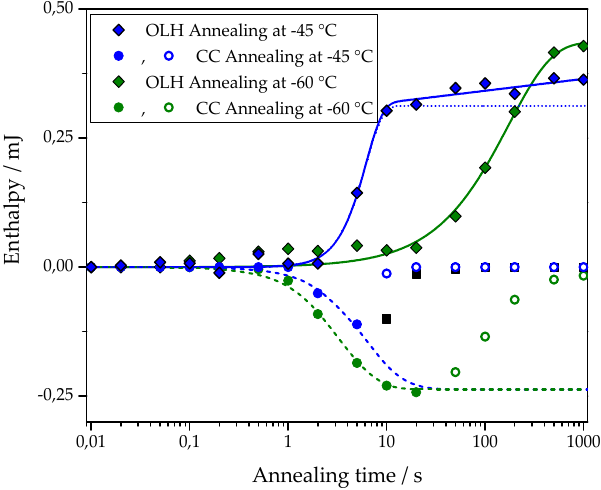
Figure 5. Approximation of the dependence of overall latent heat data (OLH, diamond) on the annealing time with Equation (1) (solid lines). Data for cross-linked PCL with 5% BPO and annealing at − 45 °C (blue symbols) and at − 60 °C (olive symbols). The dotted line shows the primary crystallization curve, plotted using Avrami equations based on the fit parameters determined for data points obtained after annealing at − 45 °C. Approximation of the cold crystallization enthalpy (CC, circles) on the annealing time with Equation (2) (dashed lines). Data for PCL with 5% BPO after annealing at − 45 °C (blue symbols) and − 60 °C (olive symbols). The fit was performed over the solid points; the hollow points were discarded.